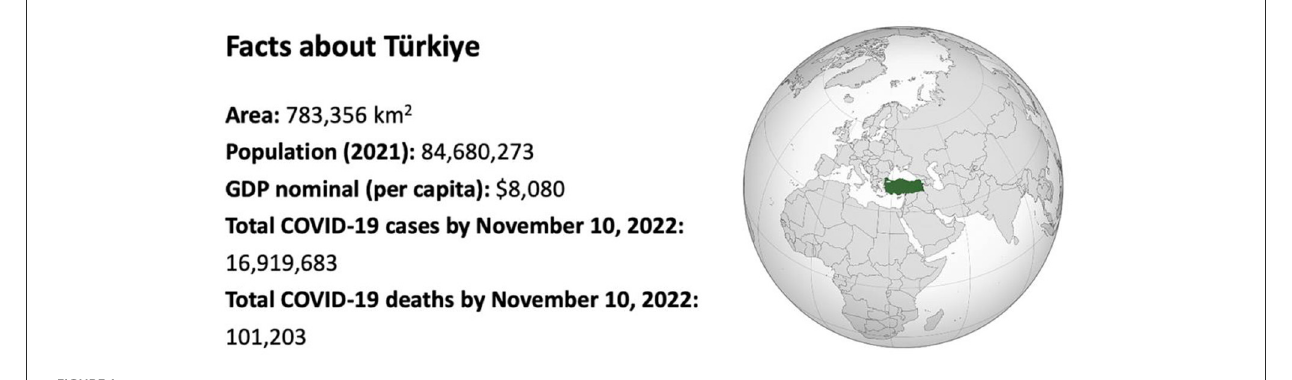
FIGURE1 Facts about